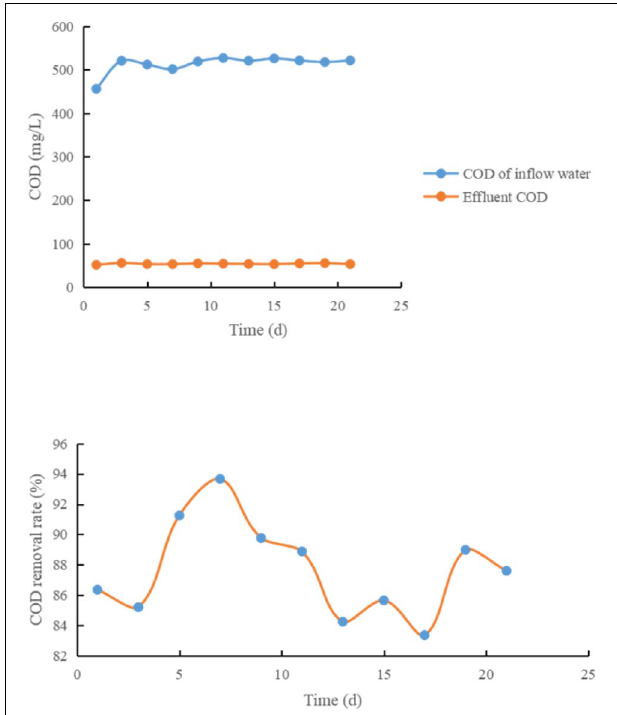
FIGURE 4 | Effect of adding glucose on COD removal rate.